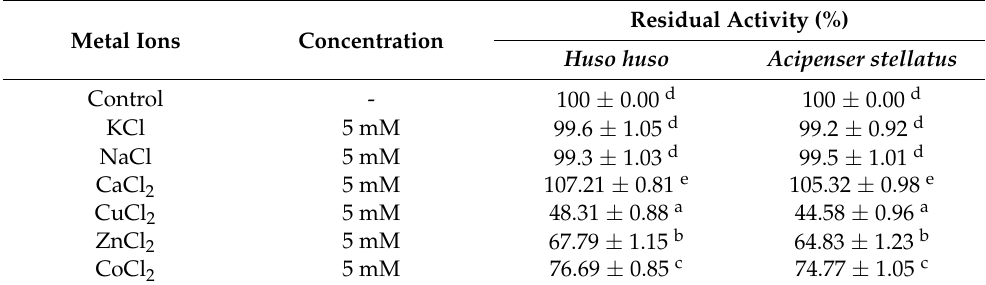
Table 2. Effect of various metal ions on activity of trypsin from Huso huso and Acipenser stellatus . Residual Activity (%) Metal Ions Concentration Huso huso Acipenser stellatus Control - 100 ± 0.00 d 100 ± 0.00 d KCl 5